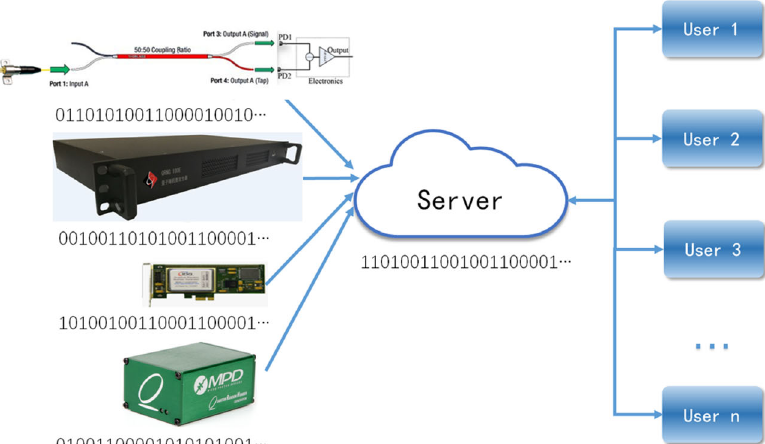
Fig. 2 Schematic Diagram of the QRNG Cloud Platform. Redundant backup server and QRNG devices are provided in different server rooms in case of system